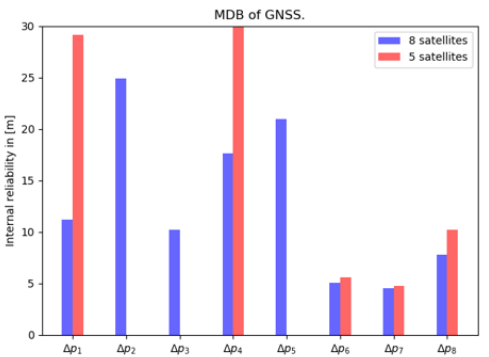
Figure 10. Internal reliability: MDB for a single outlier in GNSS pseudorange measurements, computed for a case with 8 satellites (in blue), and with 5 satellites (in red).